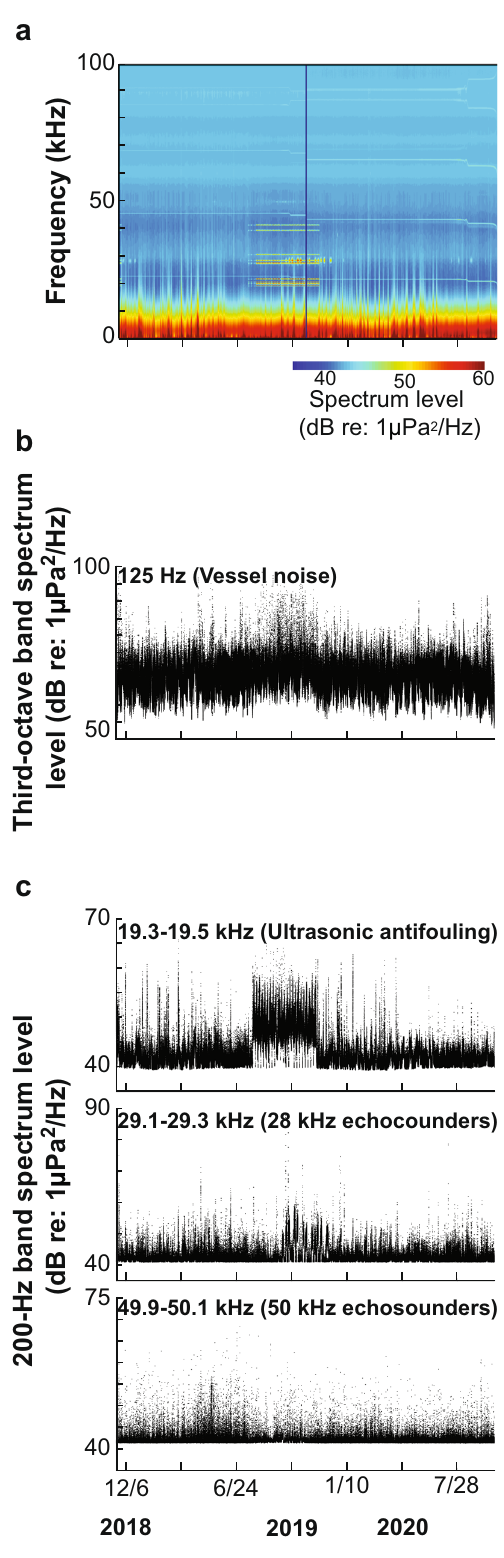
Fig. 5 Noise levels. a Long-term spectrogram of acoustic data recorded in Bahía Norte from November 19, 2018 to October 3, 2020, as well as sound energy in frequency bands representative of b low-frequency vessel noise (nominal 125 Hz third-octave band) and c high-frequency signals including UA devices and echosounders transmitting at 28 kHz and 50 kHz. The minimum noise fl oor for the c measurements (~40 dB re: 1 µ Pa 2 /Hz) was determined by electronic self-noise produced by the acoustic recording system and was not a re fl ection of the true minimum ambient noise